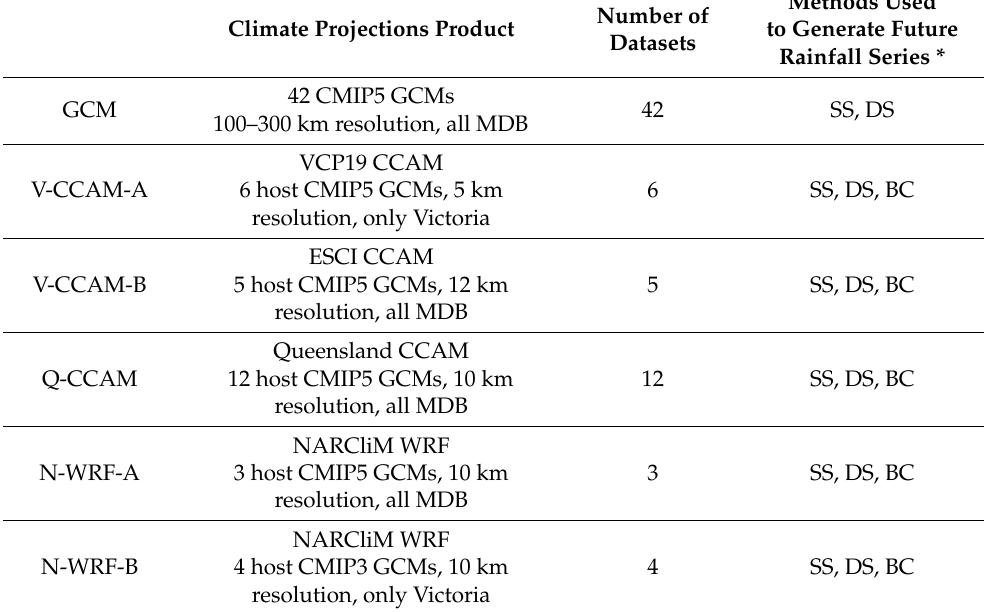
Table 1. Climate projection products and methods used to generate future daily rainfall series.